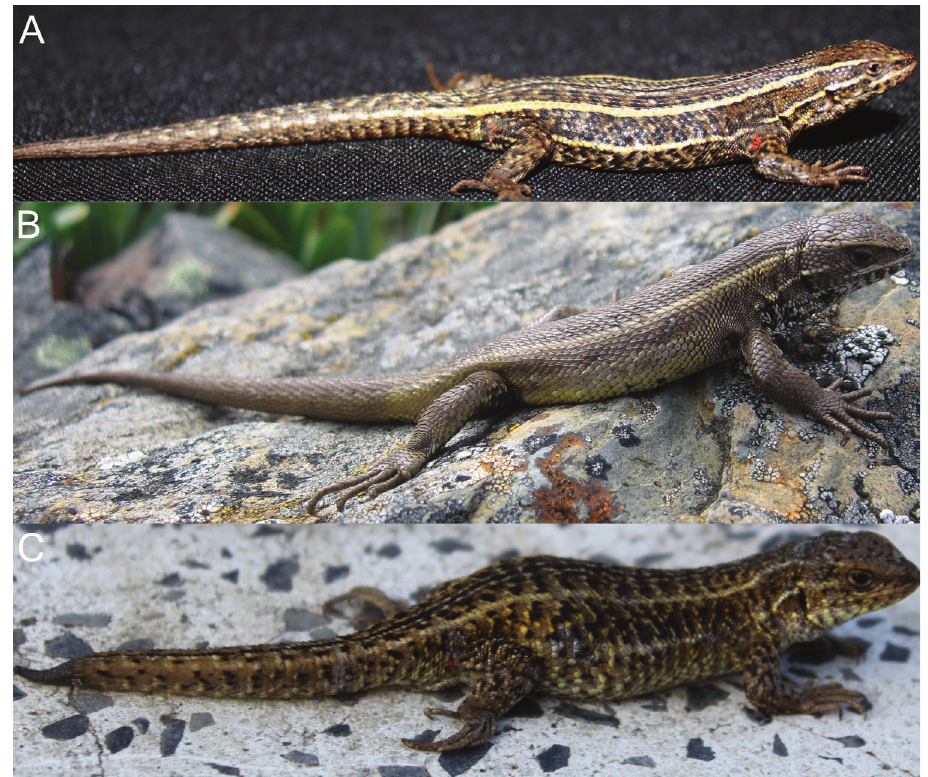
Figure 4. Lateral view showing the color patterns of a Ayacucho B Cusco, and C L. walkeri